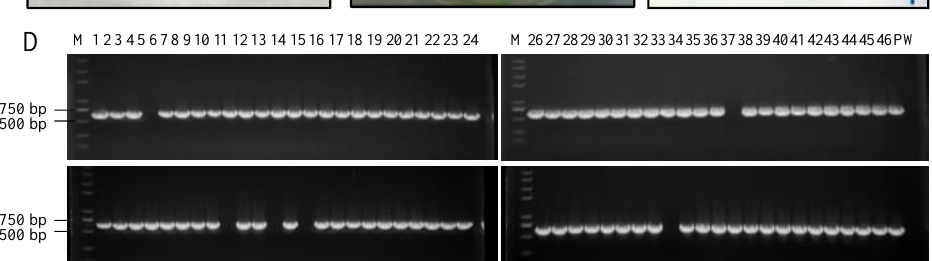
Figure 4. Stable and efficient genetic transformation of L. minor . ( A ) GUS-stained co-cultivation of callus and A. tumefaciens ; ( B ) selected nodule under 100 mg/L G418 stress after 1 month; ( C ) GUS expression in transgenic fronds after 2 months; ( D ) PCR analysis of putatively transgenic plants. M: DNA marker, P: plasmid, W: wild type, 1~92: G418-resistant plants.